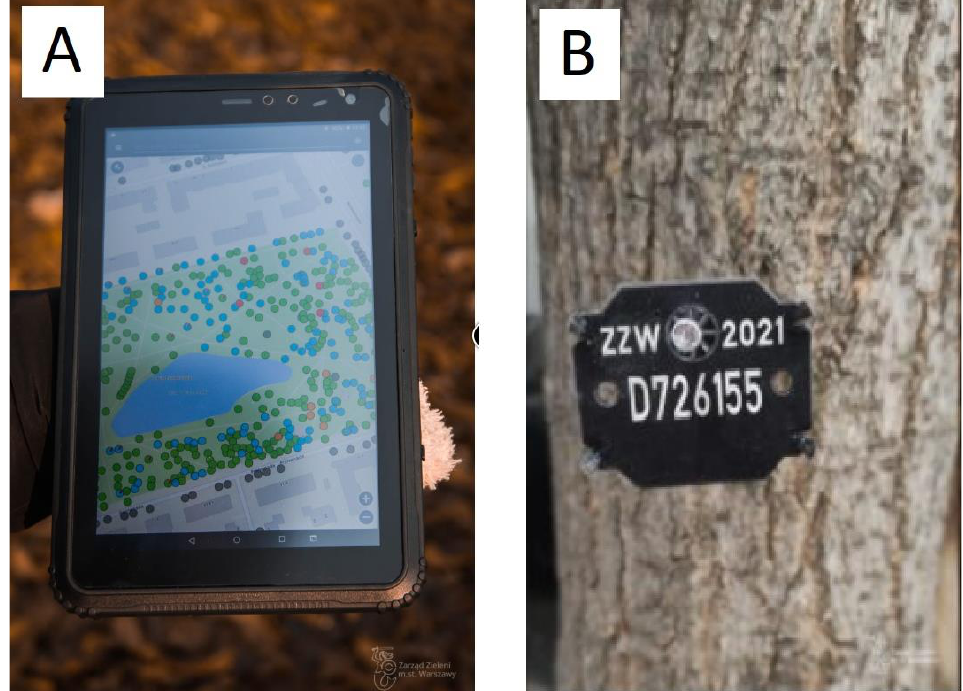
Figure 10. ( A ) — Example of prototype smartphone application with inventory and information of Figure 10. ( A )—Example of prototype smartphone application with inventory and information of trees in given area in Warsaw city, ( B ) — Example of an inventory of trees of the area with numbering trees in given area in Warsaw city, ( B )—Example of an inventory of trees of the area with numbering correlated with the mobile application (Photographs by Zarząd Zieleni Miejskiej w Warszawie) [ 81]. correlated with the mobile application (Photographs by Zarz ˛ad Zieleni Miejskiej w Warszawie)